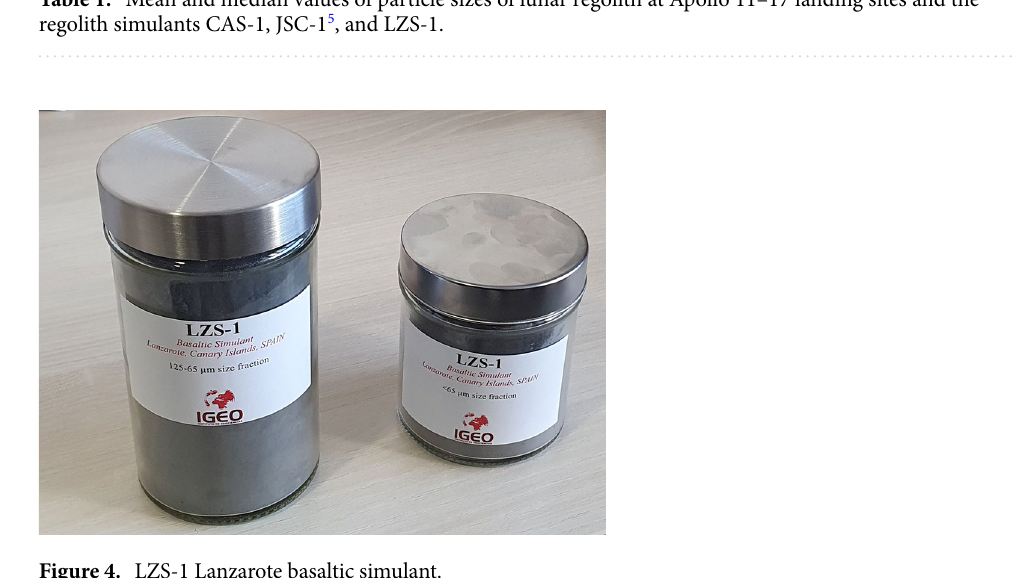
Figure 4. LZS-1 Lanzarote basaltic simulant.